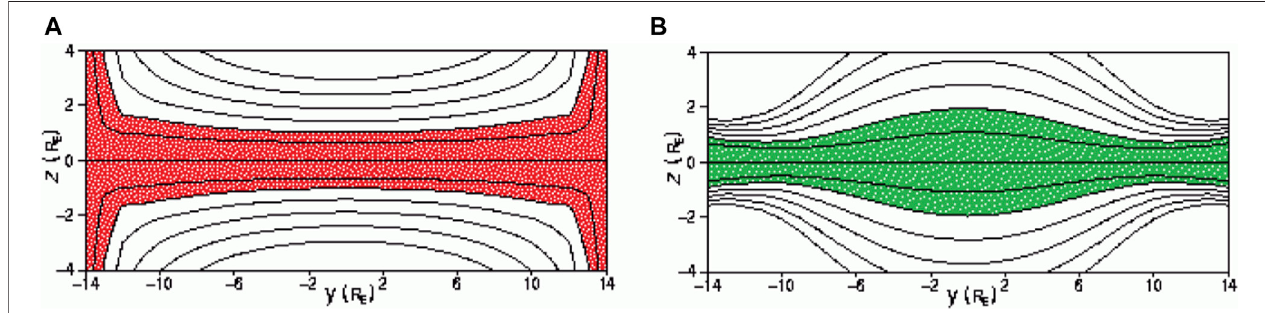
FIGURE 5 | An example of plasma pressure distribution in the plasma sheet at geocentric distance X (cid:2) − 30 R E , (A) when B IMF z < − 4 nT and (B) at B IMF z > + 4 nT , in accordance with the model of Antonova and Ovchinnikov